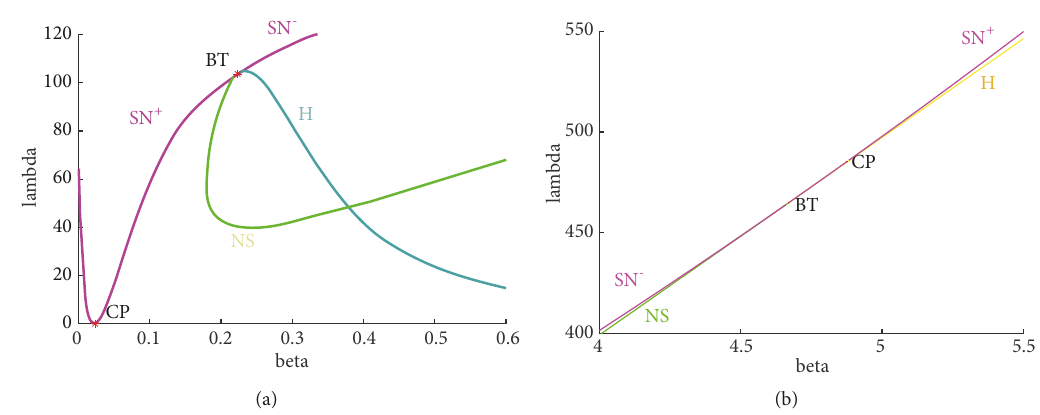
Figure 9: Zoom-in on the bifurcation diagram near the Bogdanov-Takens points. (a) 𝐵𝑇 + . (b) 𝐵𝑇 − .